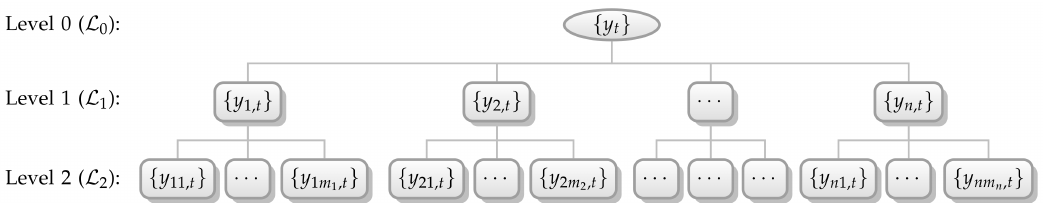
Figure 1. A three-level hierarchical demand time series structure. Universal product code (UPC)